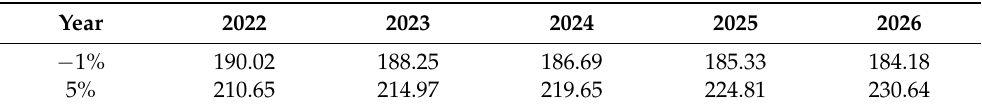
Table 24. Prediction result of water requirement with different growth rates of AVPI in Inner Mongolia.